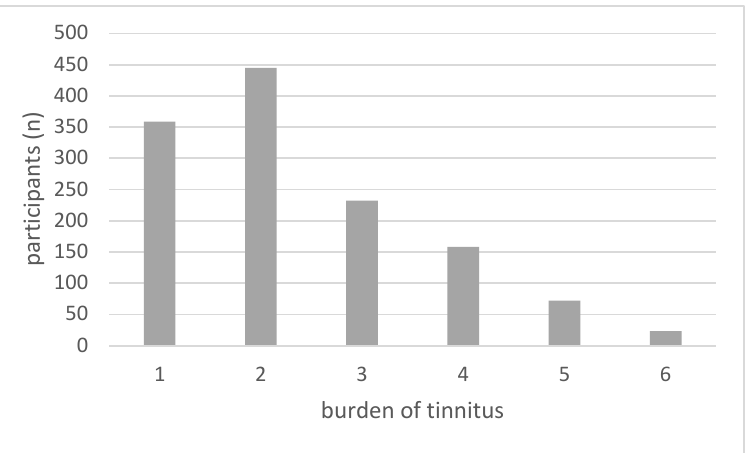
Figure 4. Burden of tinnitus among participants with tinnitus (1 = “little stressful” to 6 = “extremely stressful”).